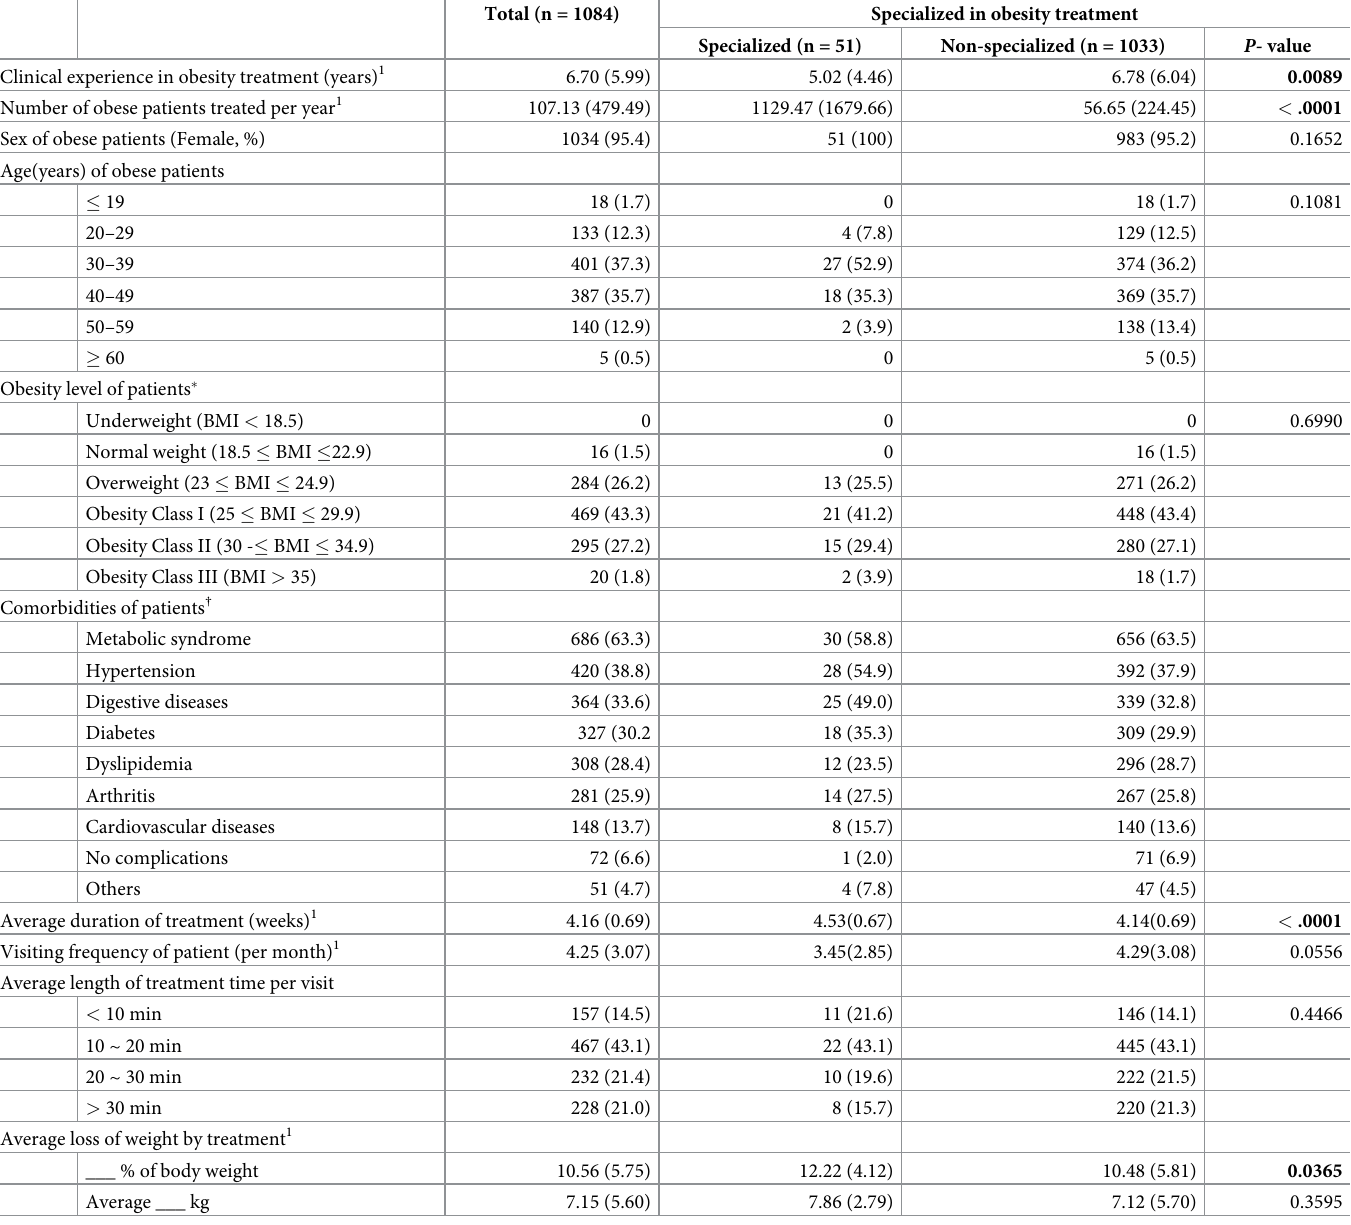
Table 2. Current status of KM clinical practice in obesity